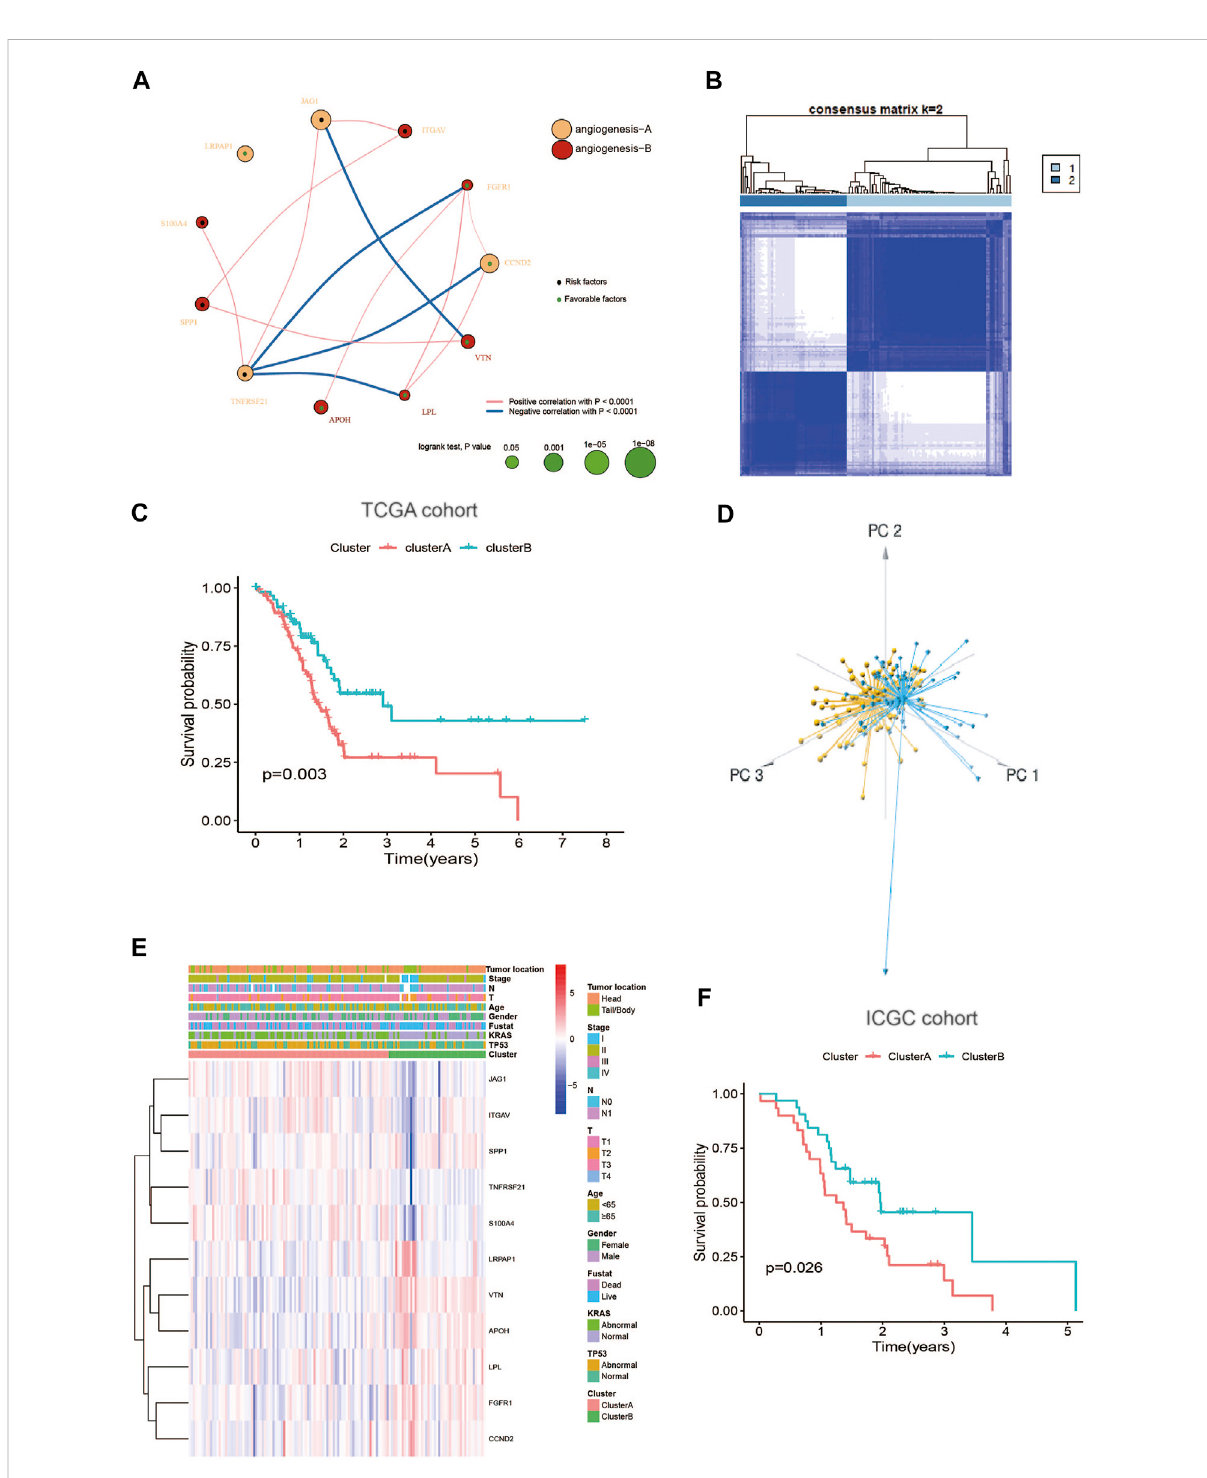
FIGURE 2 Identi fi cation of angiogenesis subtypes in PC: (A) A network of Interactions among ARGs in PC, the size of the circle represents the impact of eachangiogenesisgeneontheprognosis,the p valuecalculatedbylog-ranktest.Greendotsinthecirclerepresentprotectivefactorsandblackdots represent risk factors. Links between genes represent their interactions, blue lines represent positive correlations, red lines represent negative correlations, and the thickness of the lines represents the strength of the correlation between them; (B) Consensus matrix heatmap de fi ning two clusters (k = 2) and their correlation area; (C) Kaplan – Meier plot of OS by angiogenesis clusters for PC patients in the TCGA cohort ( p = 0.003, Log-rank test); (D) PCA analysis showing two distinct subtypes of 11 angiogenesis genes in TCGA cohort; (E) Heatmap plot of 11 angiogenesis genes expressionwithclinicalcharacteristicsinPCfromTCGAcohort. (F) Kaplan –